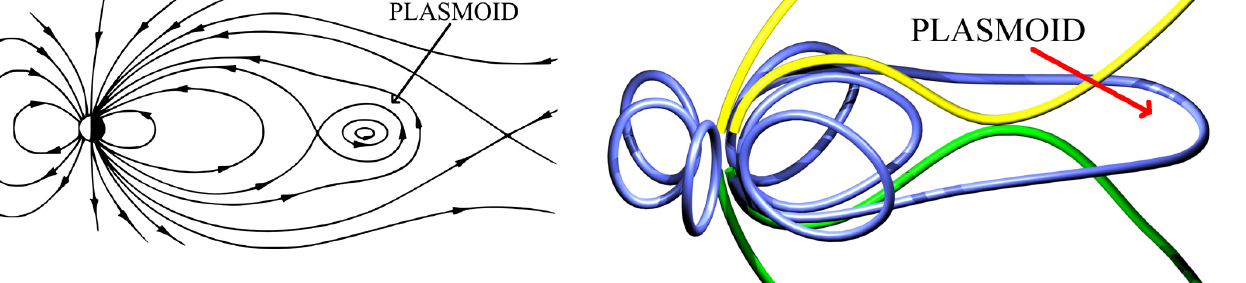
Fig. 2. A plasmoid consisting of the closed magnetic field line re- gion partially detached from the Earth. Closed magnetic field lines are colored blue. Magnetic field lines attached to the Earth only in the parallel and anti-parallel directions (lobe field lines) are colored yellow and green,